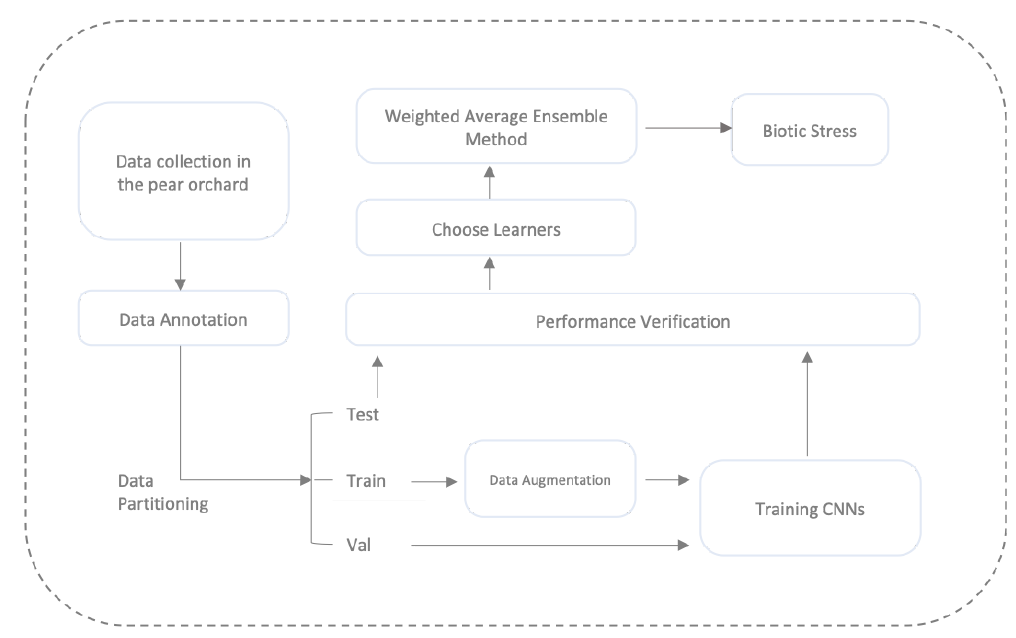
Figure 2. Workflow of the proposed